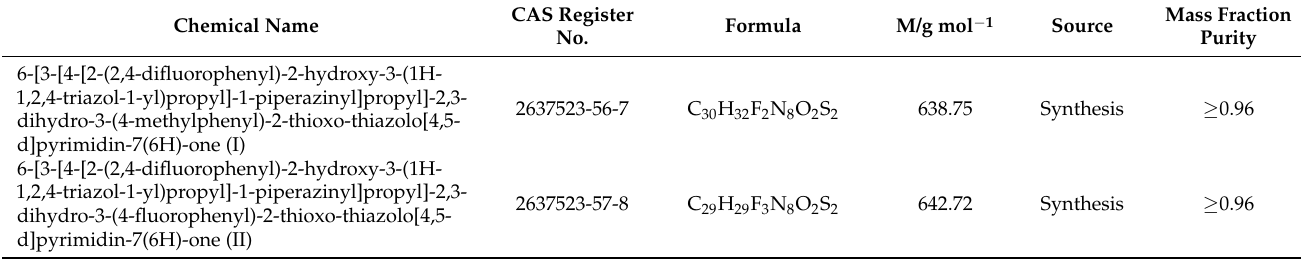
Table 7. Information about chemicals used in this